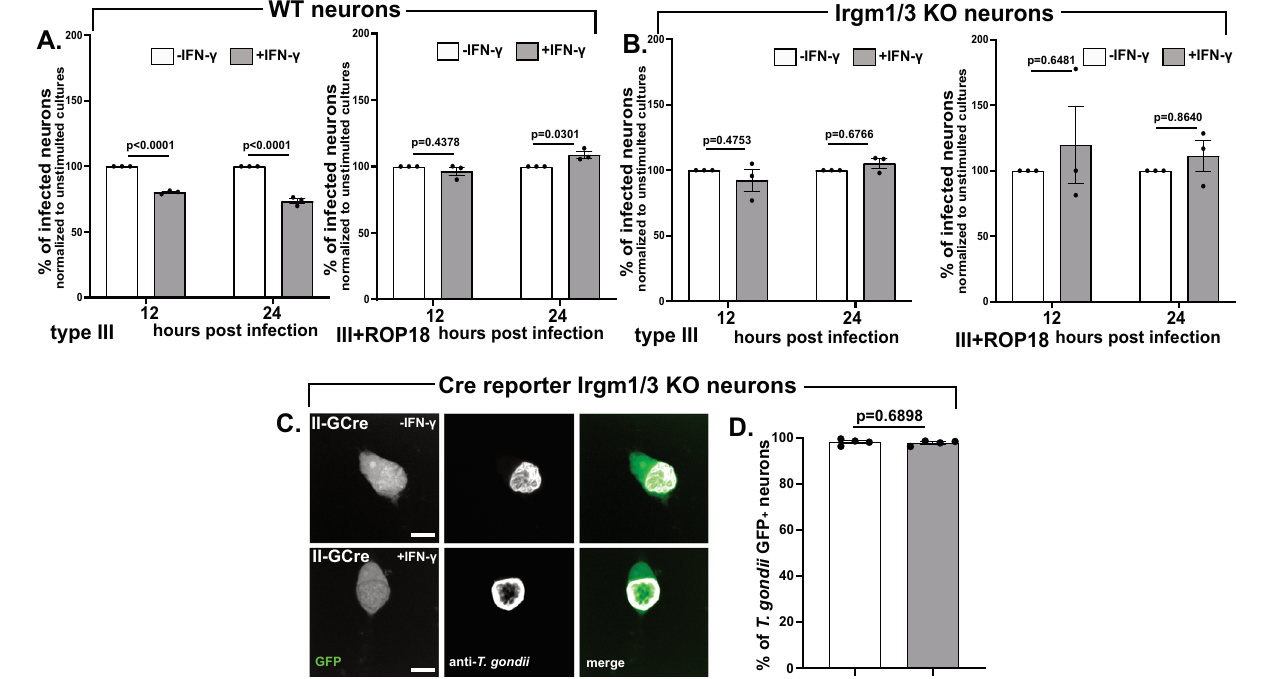
Fig. 4 | An intact IRG system is required for IFN- γ -dependent murine neurons clearance of intracellular parasites. Primary neuron cultures from WT (Cre reporter), Irgm1/3 KO, or Cre reporter Irgm1/3 KO mice were treated as in Fig. 1 followed by infection with listed T. gondii strains. A Graph of the percentage of infected WT neurons at listed time points for type III parasites ( left graph ) and III+ROP18 parasites ( right graph ), normalized to the unstimulated culture. B As in A except using Irgm1/3 KO neurons and either type III parasites ( left graph ) or III+ROP18parasites( rightgraph ). A , B Atthelistedtimepoints,cultureswere fi xed, stained, and analyzed as in Fig. 2A. Bars mean±SEM., N =731 – 1448 neurons/ T.